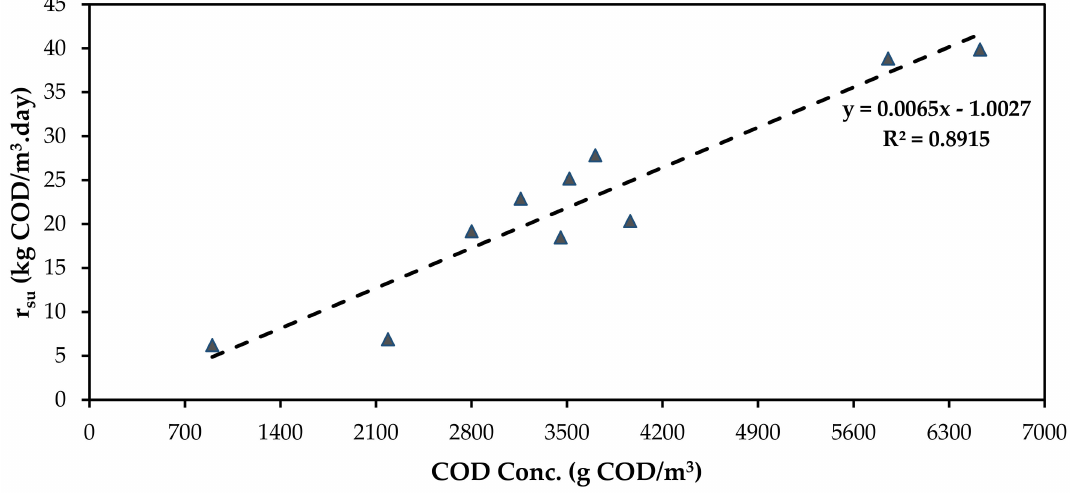
Figure 8. Substrate utilization rate as a function of COD concentration (g COD/m 3 ).